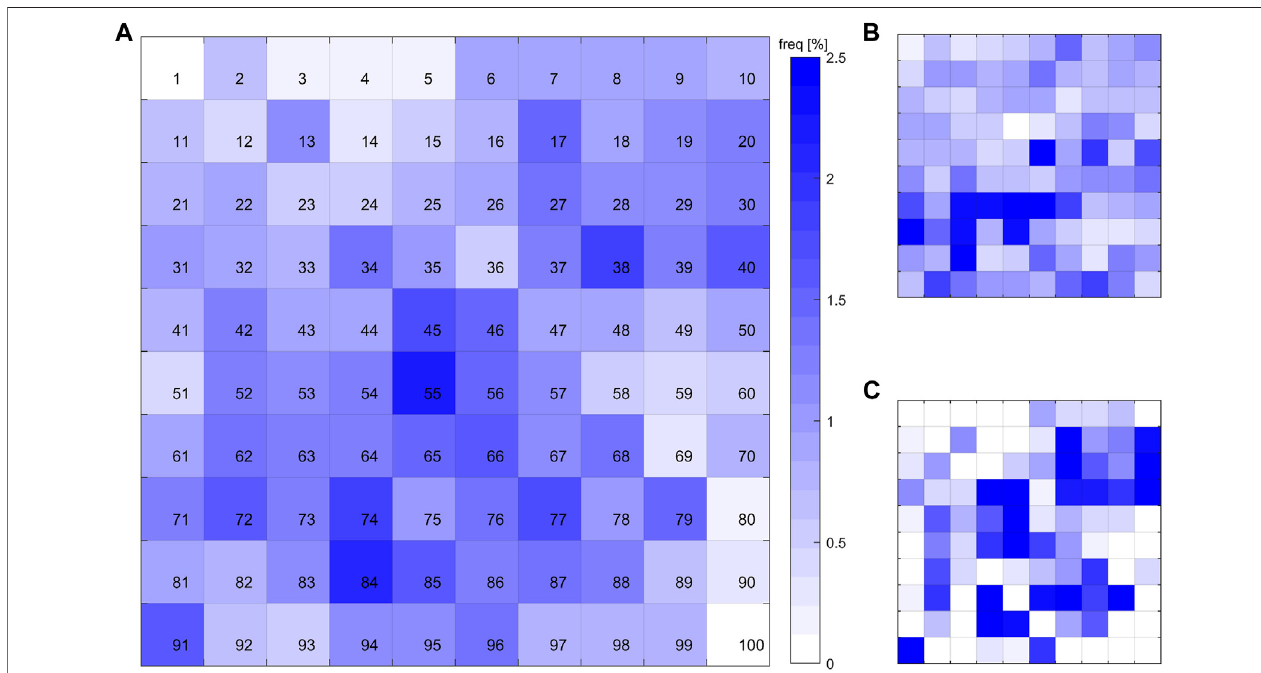
FIGURE5| Annual (A) winter (B) andsummer (C) rateprobabilityoccurrenceofthe100weathertypes( Figures3 , 4 showtheatmosphericcirculationpatternsfor each weather type).